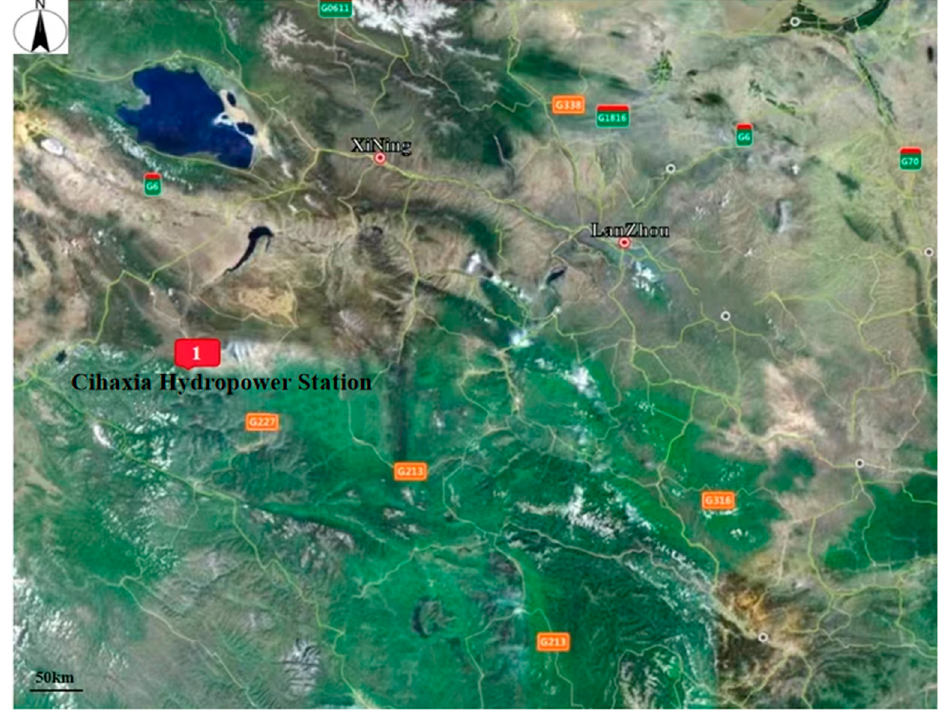
Figure 4. The location of Cihaxia Hydropower Station.